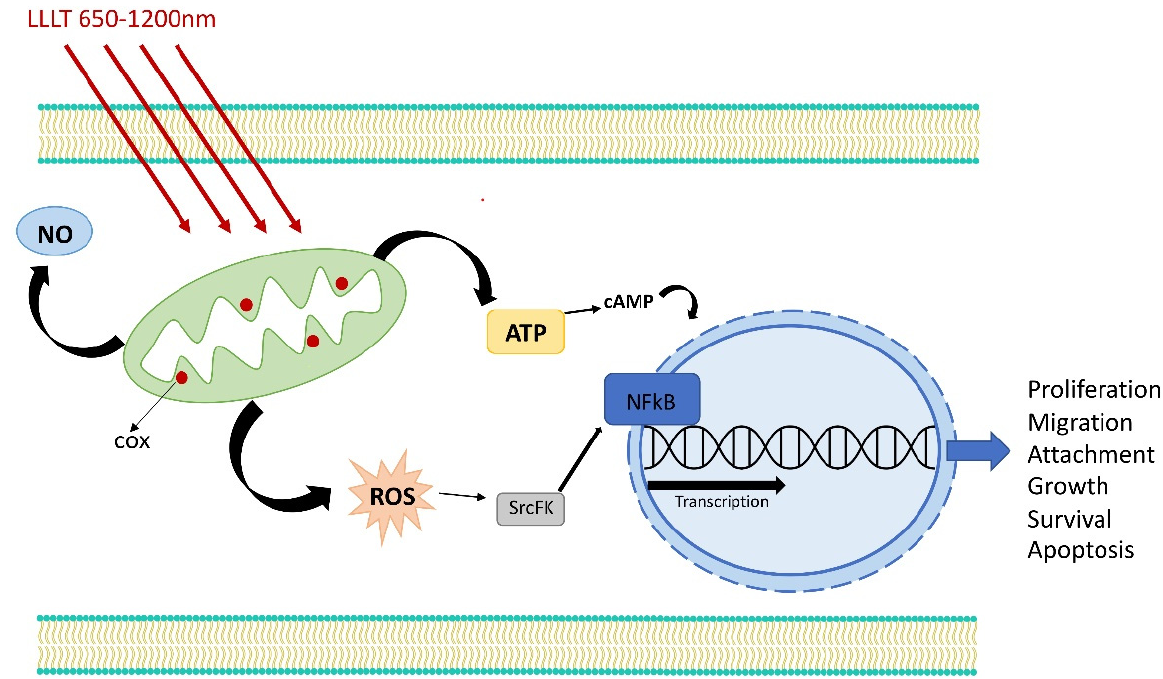
Figure 2. Mechanism of LLLT action on cell activity.